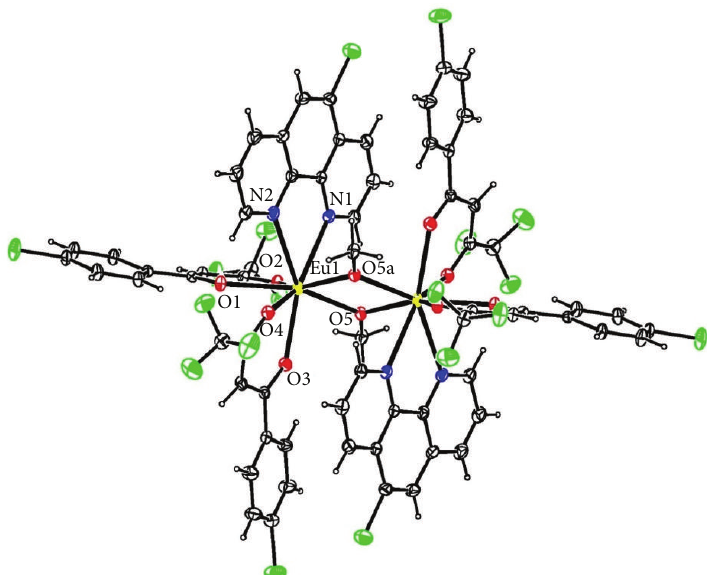
Figure 3: Structural diagram of complex 2, namely, tetra(1,4-chlorophenyl-4,4,4-trifluoro-1,3-butanedionate) di(5-chloro-1,10-phenanthro- line) di- 𝜇 2 -methanolate dieuropium(III). H atoms have been omitted for clarity reasons and displacement ellipsoids were drawn at the 10% probability level.